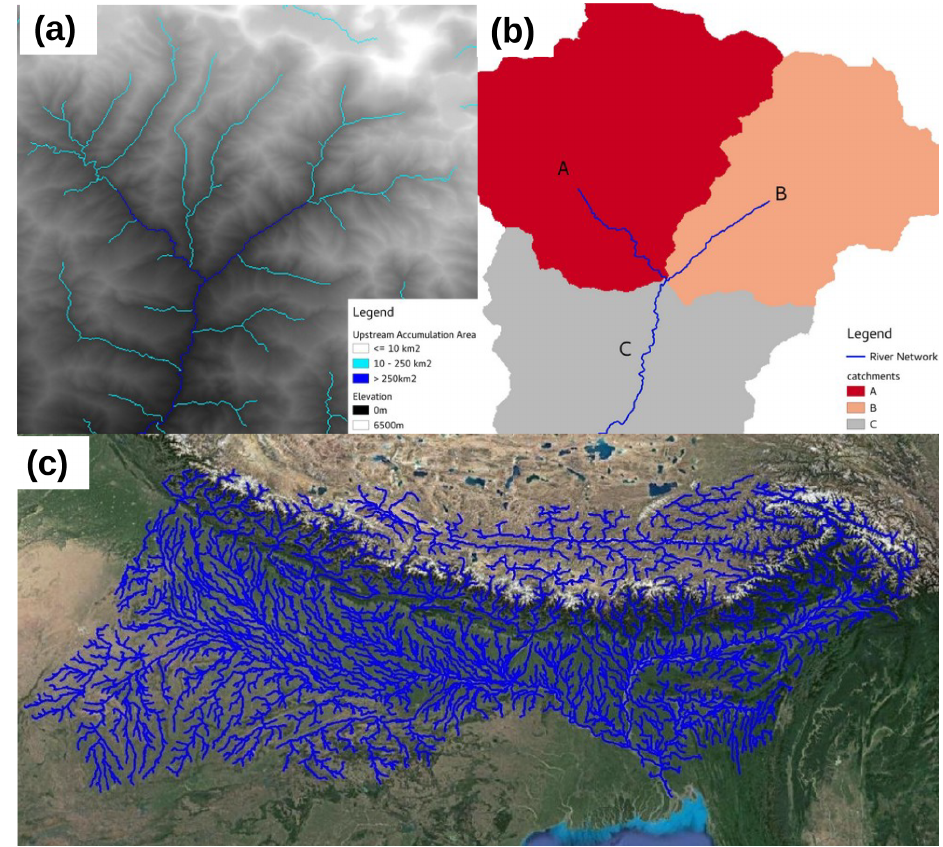
Figure 3. MERIT-Hydro GBM stream network. (a) Example of river points determined from upstream area values. (b) Corresponding vector stream network and drainage catchments (using an upstream area threshold of 250km 2 ). (c) Map showing the full river network over the GBM basin. Map data ©Google Earth